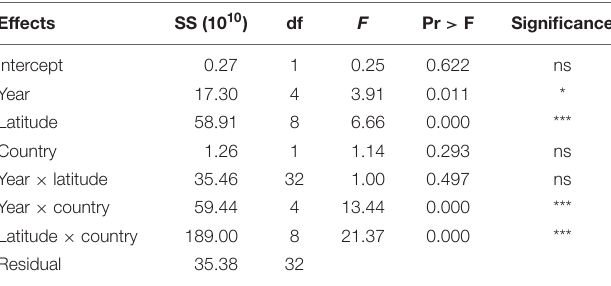
TABLE 1 | Two-way ANOVA (Type III tests) of the main effects of year, latitude and country, and their two-way interactions on the effort (number of fishing hours) observed in the Yellow Sea during